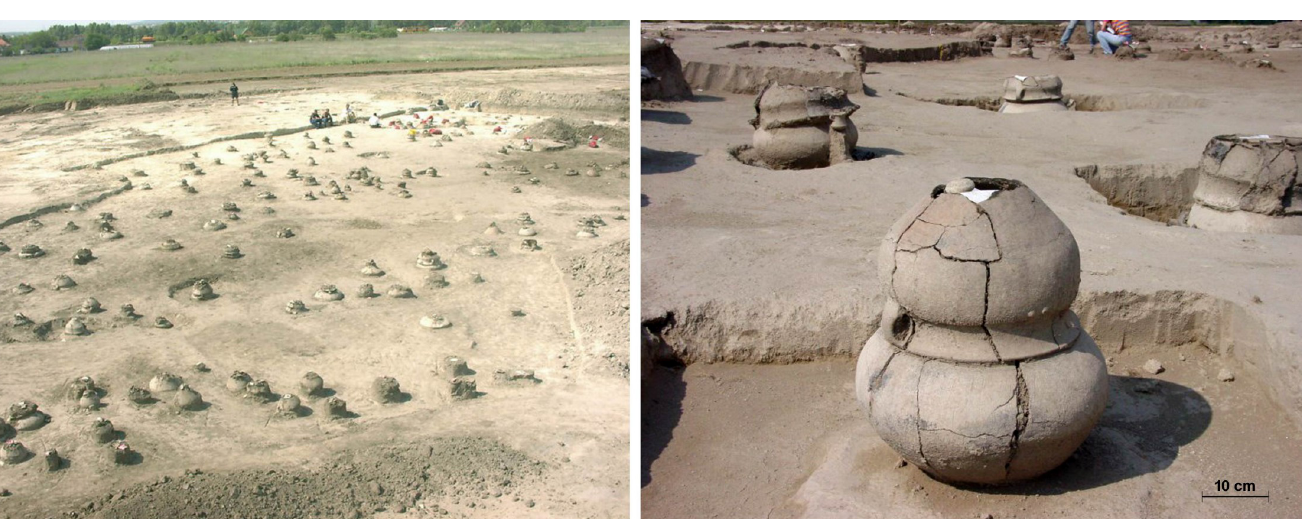
PLOS ONE | https://doi.org/10.1371/journal.pone.0254360 July 28,